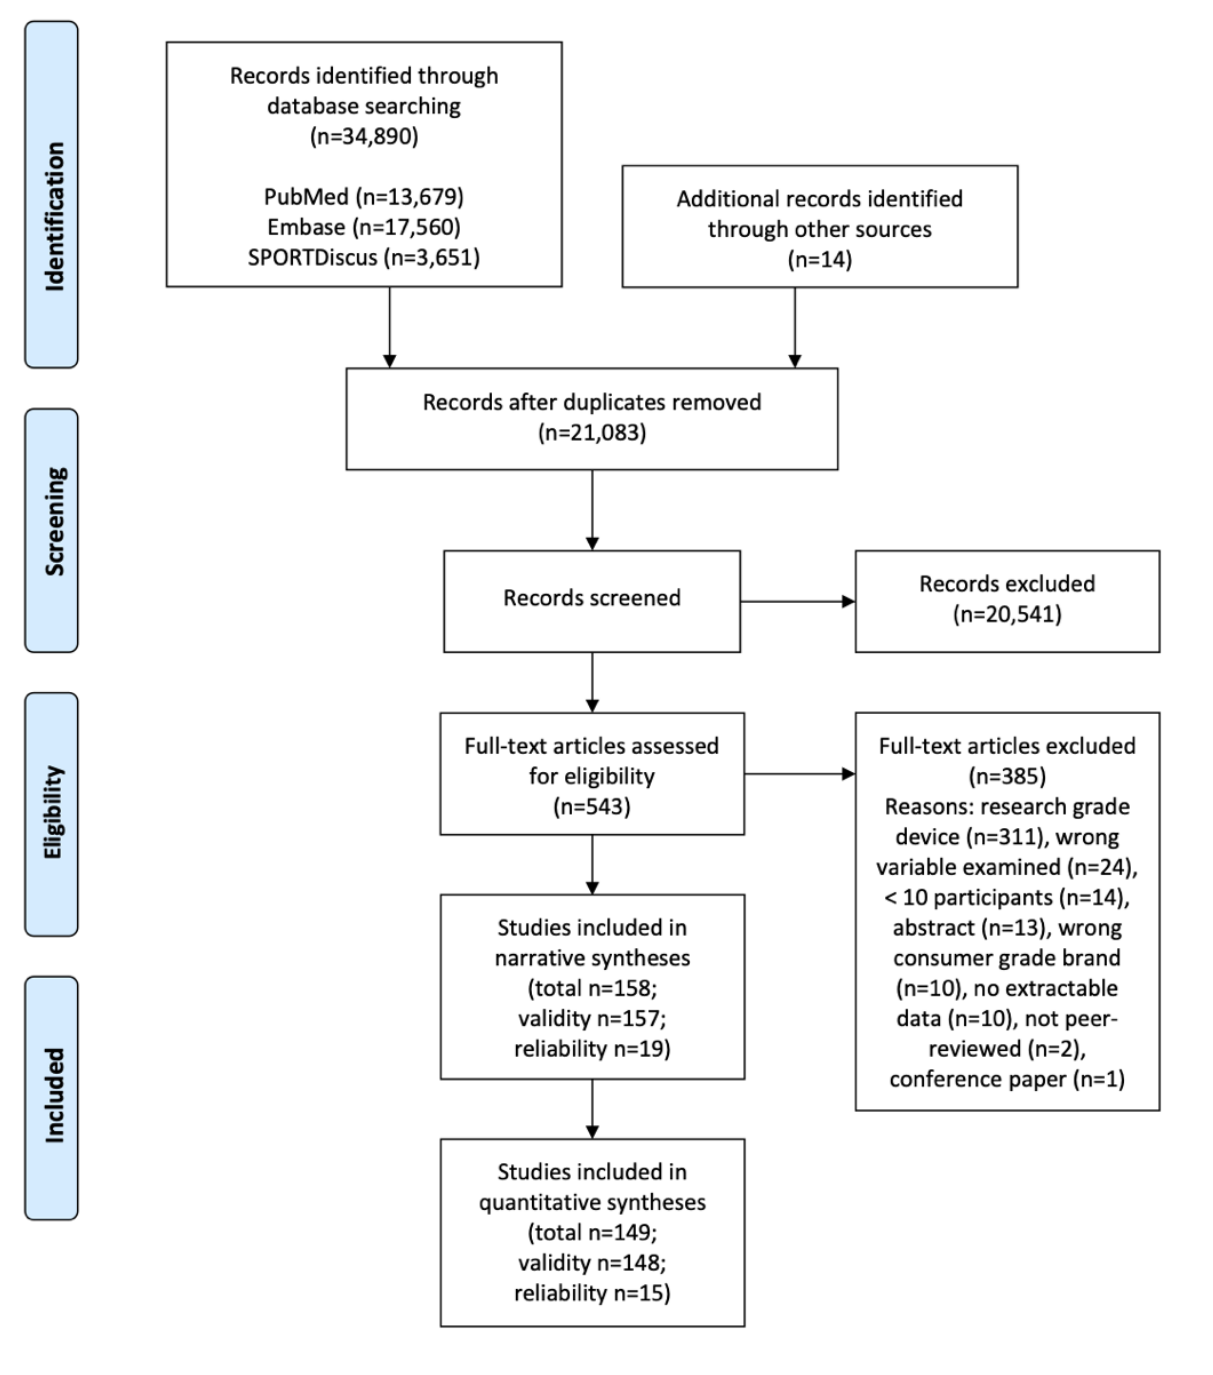
Figure 1. PRISMA flow chart for systematic review of the reliability and validity of commercial wearable